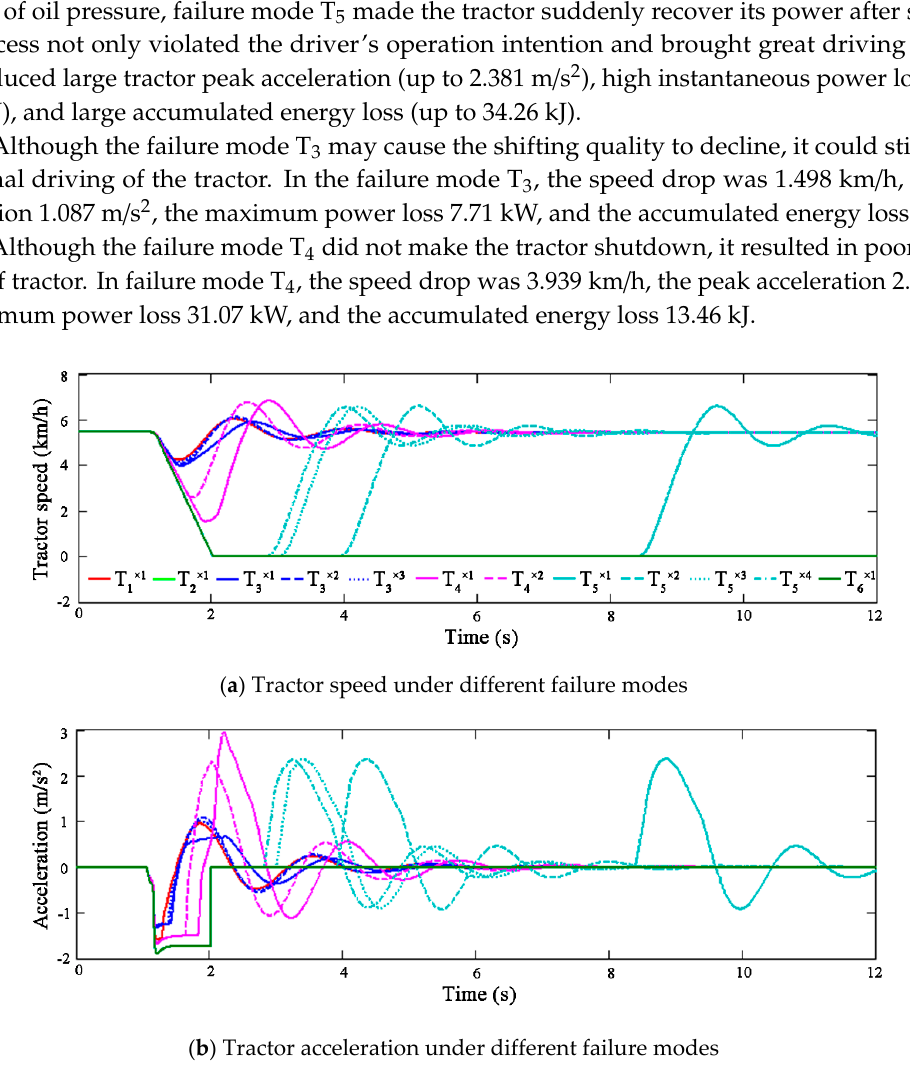
Table 5. Clutch parameters used in the simulation.